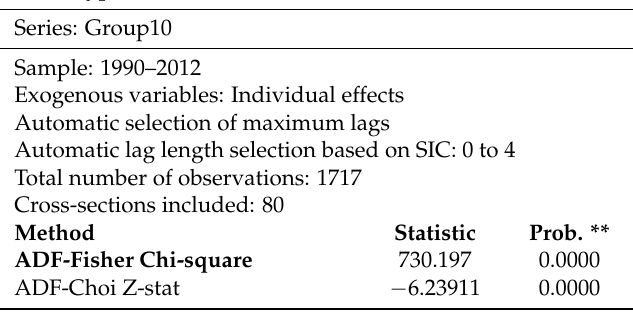
Table 5. ADF-Fisher panel unit root